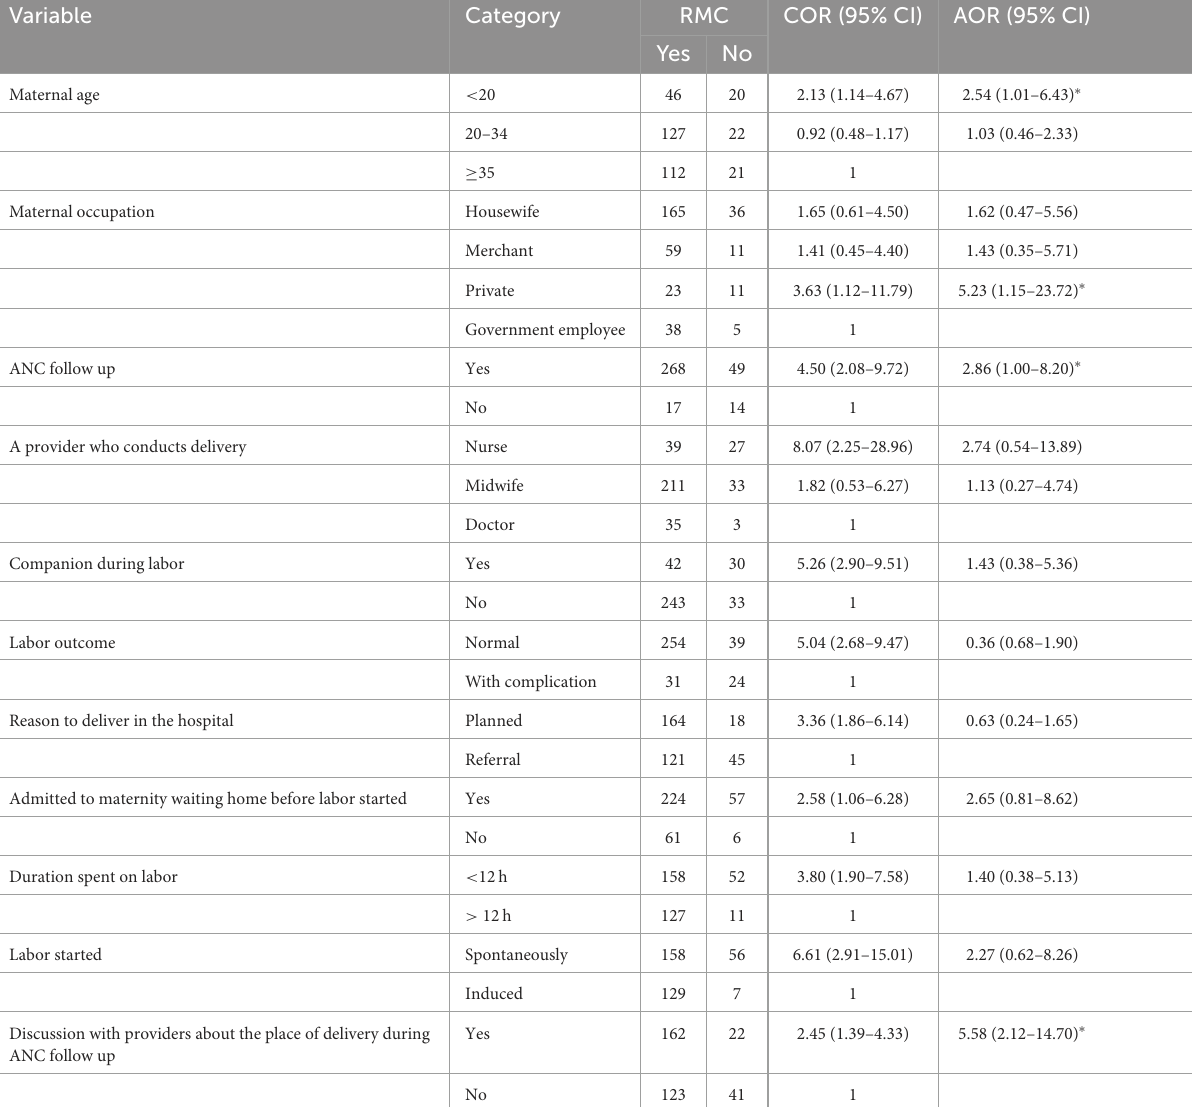
TABLE 4 Bivariable and multivariable analyses showing crude and adjusted odds ratios for an association between RMC and risk factors among mothers who give birth in three public hospitals in Southwest Ethiopia, 2021 ( n = 348).